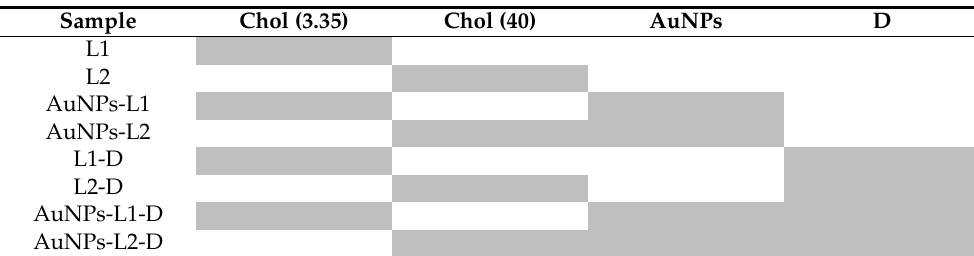
Table 1. Sample nomenclatures depending on the composition of the different preparations.